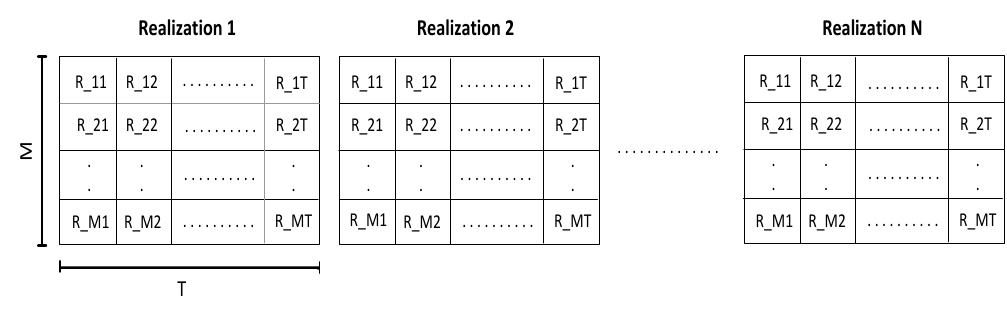
Figure 3. The structure of RSSI databases at each training